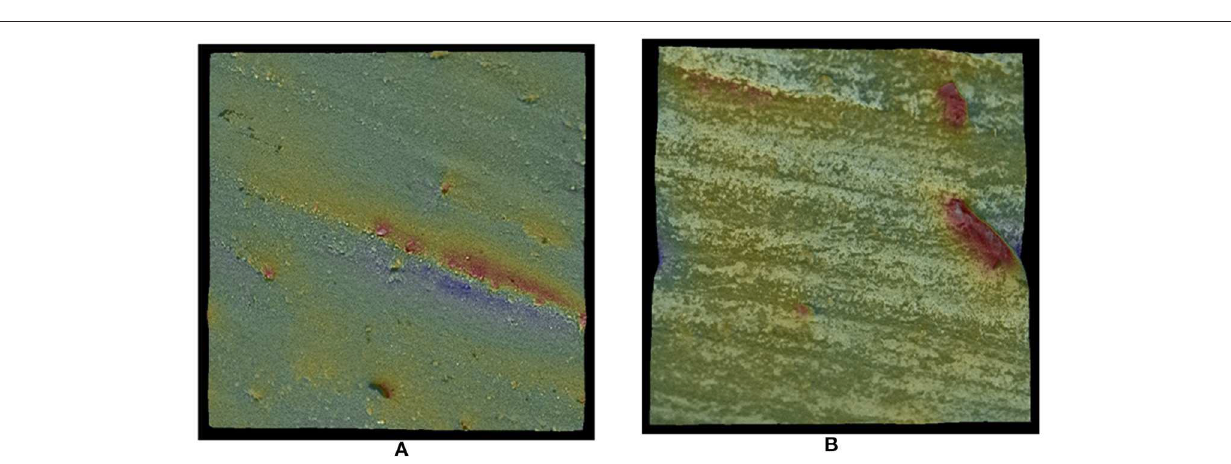
Frontiers in Materials |